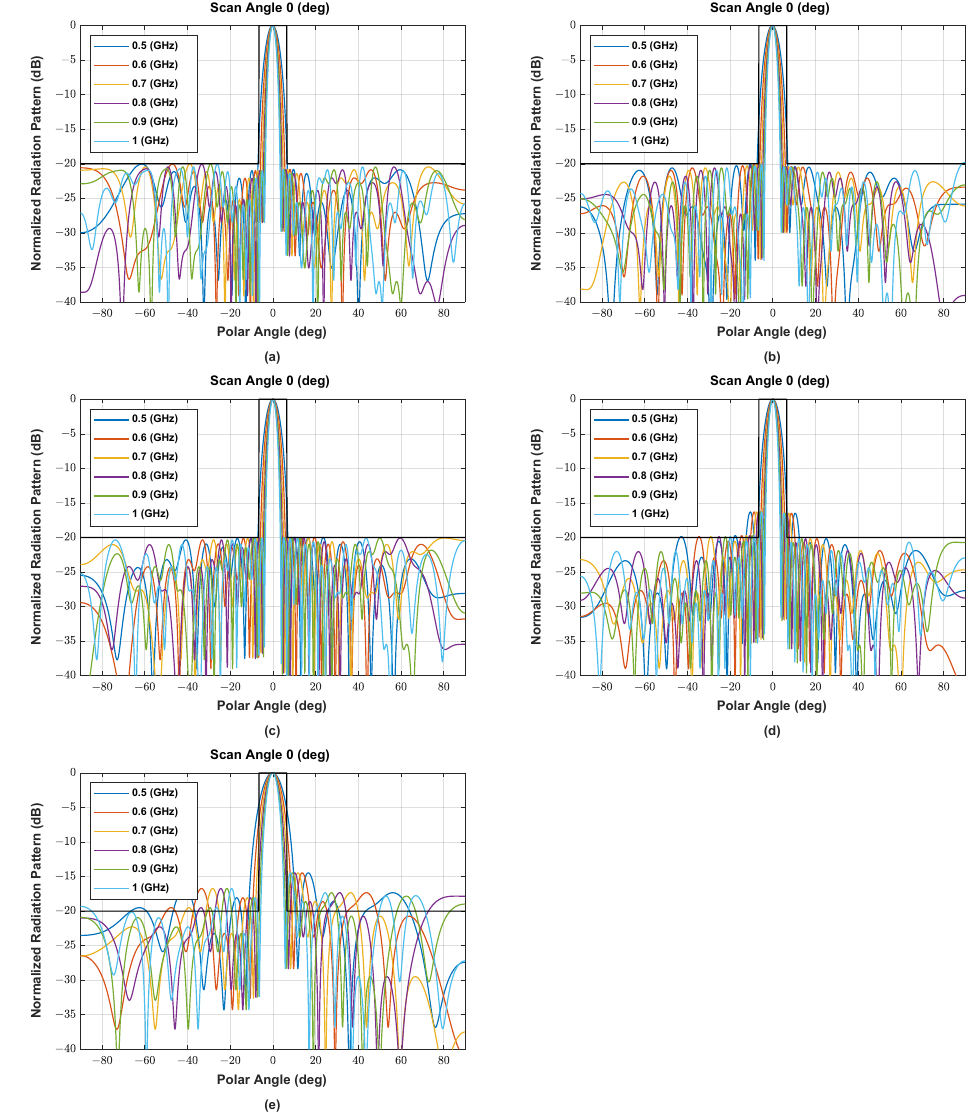
Figure A4. The beam pattern of asymmetric NUSLA using ( a ) MORELA, ( b ) QPSO, ( c ) FA, ( d ) SSA, and ( e ) MALO in case for θ 0 = 0°.